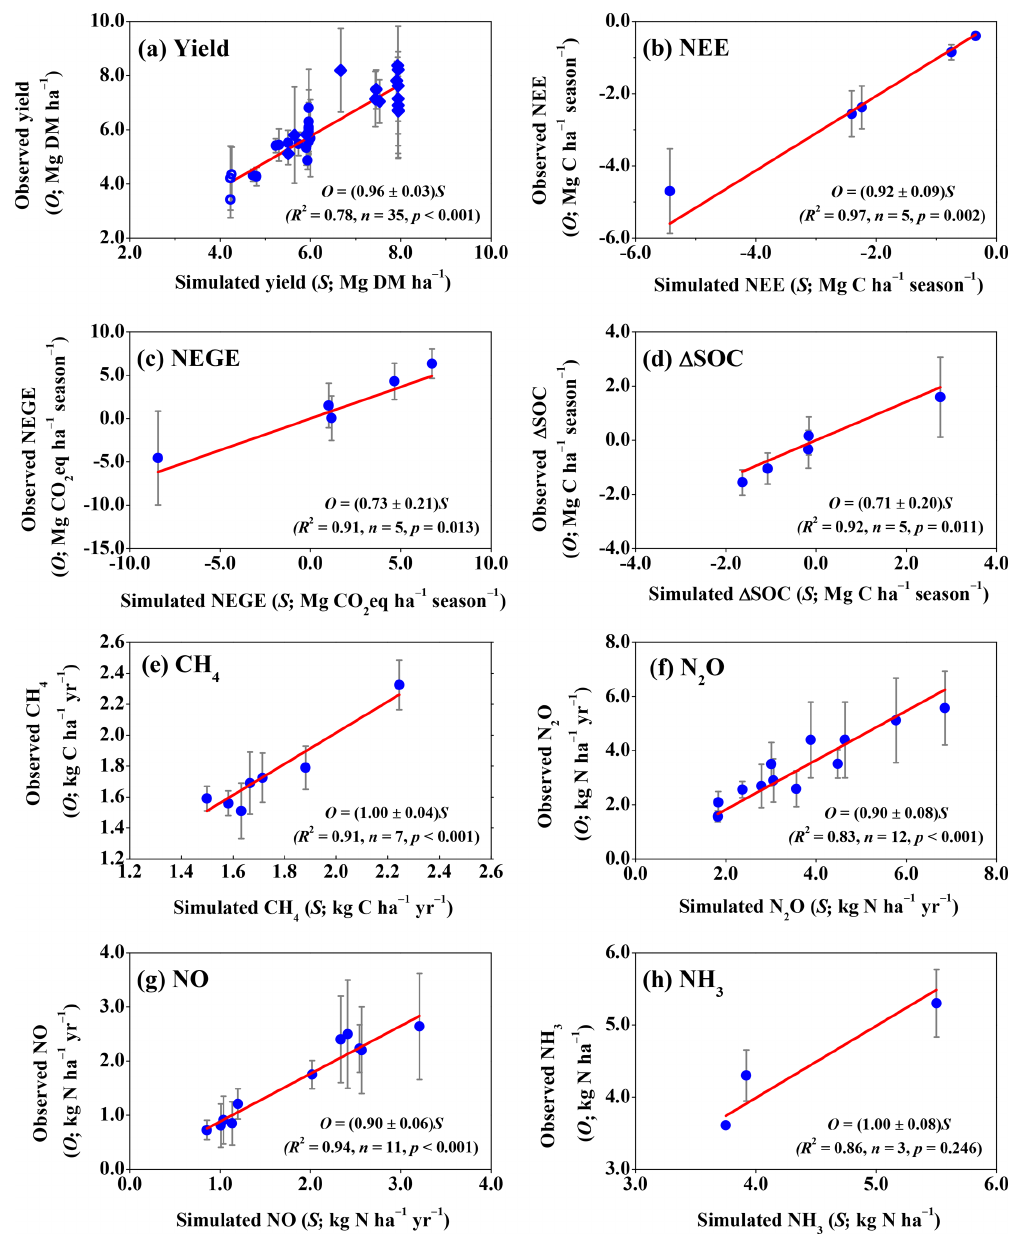
Figure 2. Comparison between observations and simulations of crop yields, annual/seasonal cumulative NEE and NEGE, annual/seasonal (cid:49) SOC, annual cumulative fluxes of methane (CH 4 ) uptake, nitrous oxide (N 2 O) and nitric oxide (NO), and cumulative fluxes of ammonia (NH 3 ). Yield refers to the seed yield of cotton (open circle) and the grain yield of winter wheat (solid circle) and summer maize (solid diamond). NEE refers to the net ecosystem exchanges of carbon dioxide. NEGE refers to the net ecosystem aggregate greenhouse gas emission. (cid:49) SOC refers to the change in soil organic carbon stock. NEE, NEGE, and (cid:49) SOC are annual for cotton and seasonal for wheat and maize. The observed (cid:49) SOC was given as the opposite of NEE plus yield in carbon mass quantity for the cropping system with the incorporation of full residues, whereas each (cid:49) SOC simulation was the sum of simulated changes in carbon stocks of soil humus, microbial biomass, and dissolvable organic compounds. Simulations resulted from the modified model. The slope errors of the zero-intercept linear regressions are ± 2 SD to represent the 95% confidence interval. Vertical bars indicate the standard deviation of three or four spatial replicates, with the exception of NEE. The errors of NEE were adapted from the coefficient of variation (on average 25%) reported by Wang et al. (2013b). DM refers to dry matter. CO 2 eq refers to the carbon dioxide equivalent. The 100-year global warming potentials of 34 for CH 4 and 298 for N 2 O (IPCC, 2013) were used to quantify NEGE in CO 2 eq